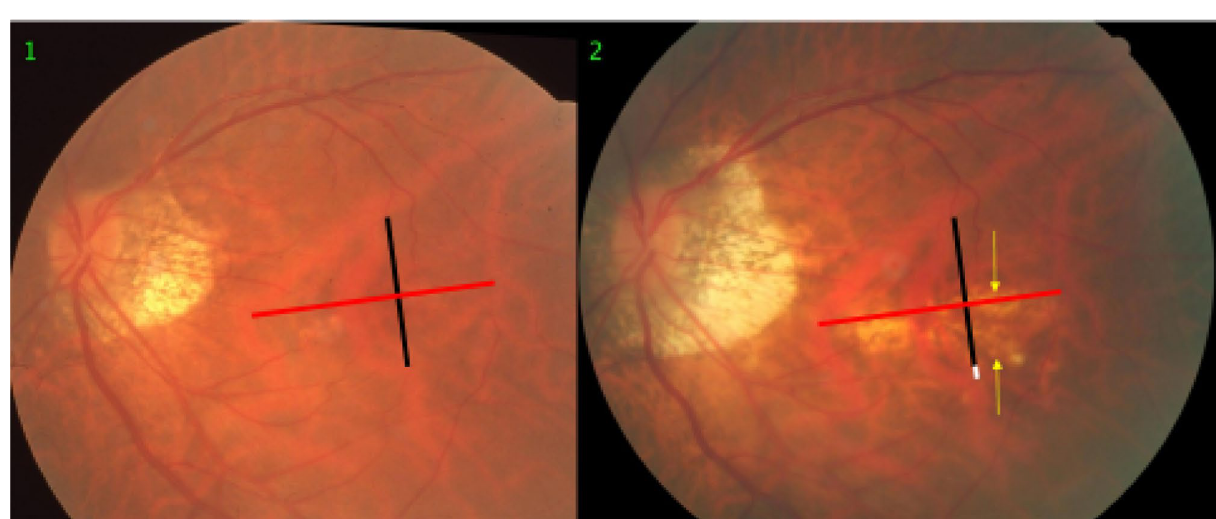
Figure 3. Fundus photographs of a highly myopic eye taken with an interval of 10 years (left image taken in 2001; right image taken in 2011). Note : Development and enlargement of a diffuse chorioretinal atrophy (yellow arrows) as category 2 of myopic macular degeneration. Elongation of the distance between two vertical choroidal vascular markings, compared between baseline (vertical black bar) and follow-up (equally long vertical black bar plus white bar); no change in the distance between two horizontal markings (equally long red bars). The choroidal vessel shift occurred perpendicular to the longest diameter of the area with diffuse chorioretinal